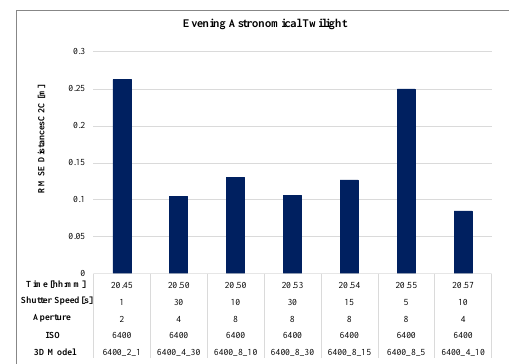
Figure 4 – RMSE of the absolute distance values for the photogrammetric models computed with the C2C method during the evening nautical twilight.